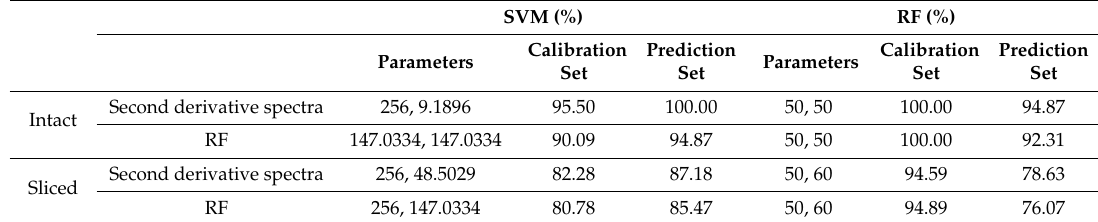
Table 3. Results of the RF and SVM models using selected optimal